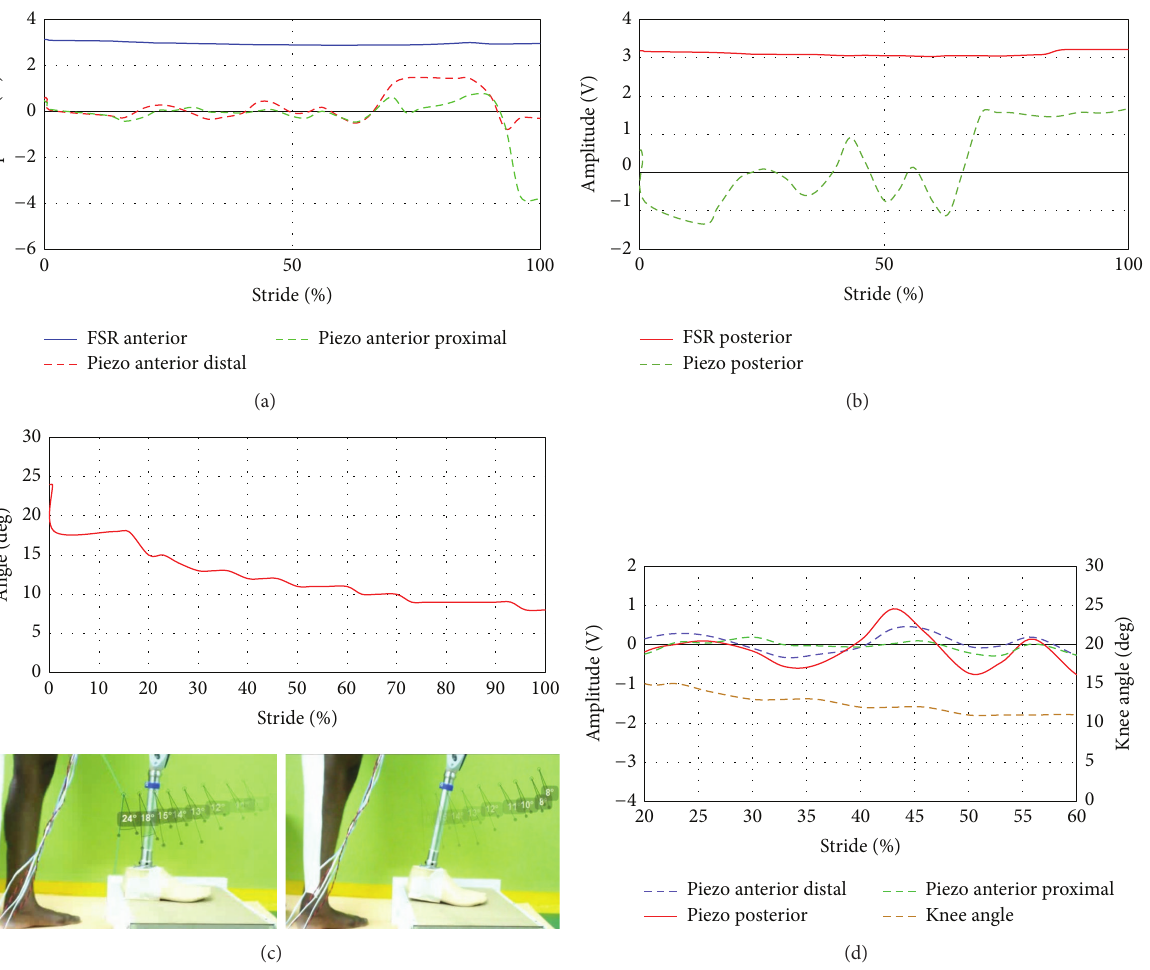
Figure 9: FSR and piezoelectric sensors output during stair ascent: (a) FSR anterior, piezo anterior distal, and piezo anterior proximal sites, (b) FSR and piezoelectric sensors at posterior sites, (c) knee angle during stride, and (d) piezoelectric sensors with the knee angle at a region from 20% to